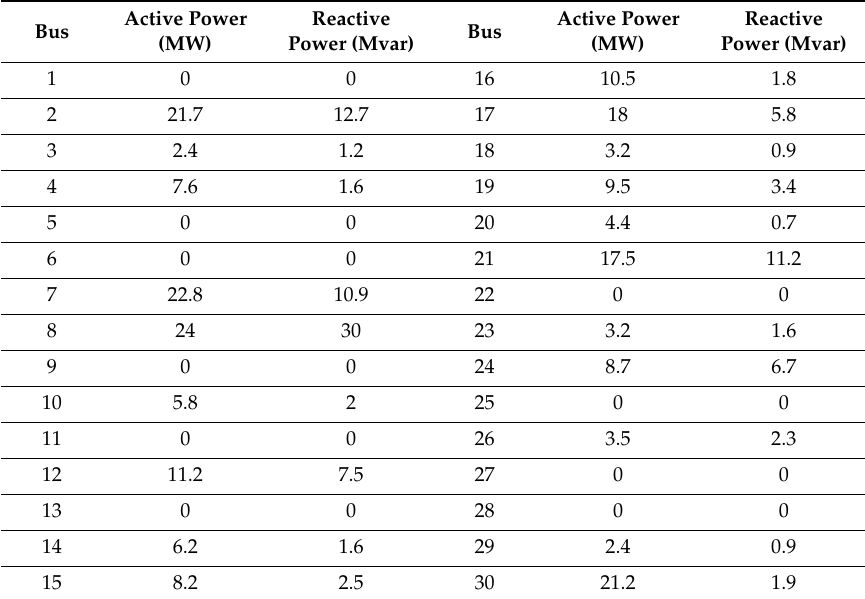
Table 1. Active and Reactive Power Demands.